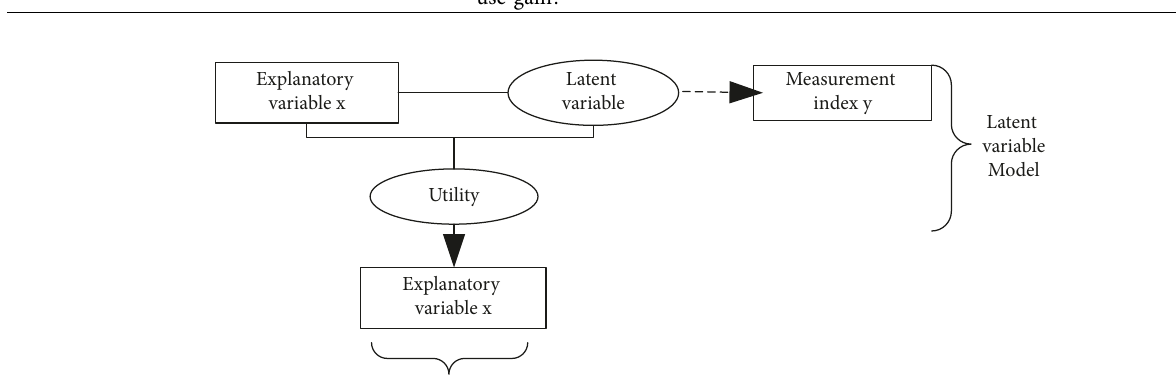
Figure 2: Structure of HCM.